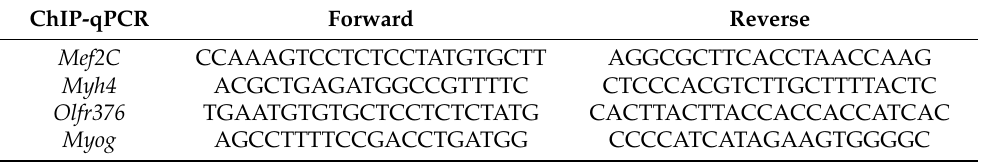
Table 4. Primers used for ChIP-qPCR.